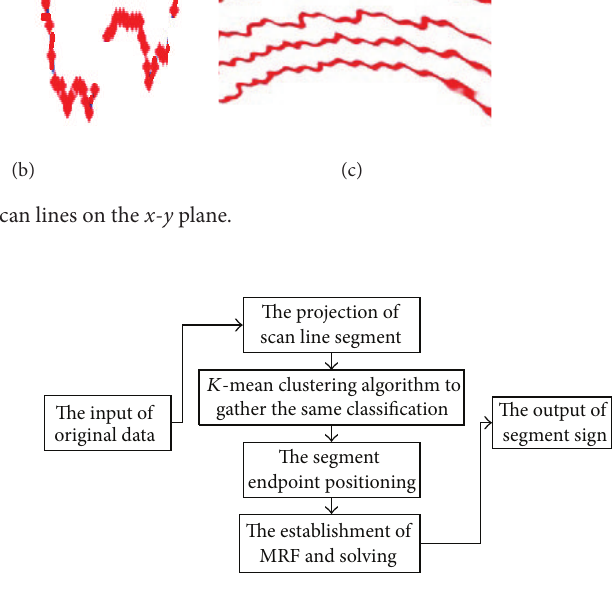
Figure 2: Flowchart of the ground segmentation